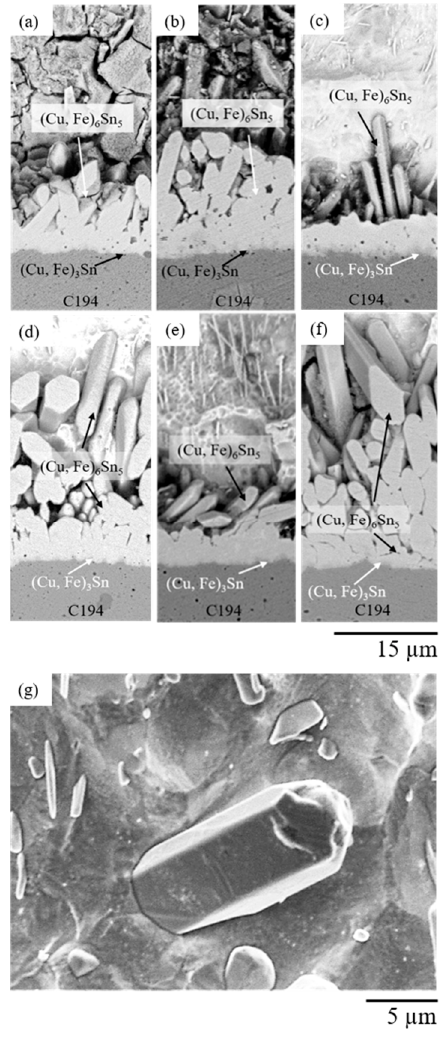
Figure 2. BEI micrographs of the shallow etched SC/C194 interfaces reacted at 240 ◦ C for ( a ) 0.5 h and ( b ) 2 h; reacted at 255 ◦ C for ( c ) 0.5 h and ( d ) 2 h; and reacted at 270 ◦ C for ( e ) 0.5 h and ( f ) 2 h; ( g ) BEI partial enlarged micrograph of the SC/C194 couples.